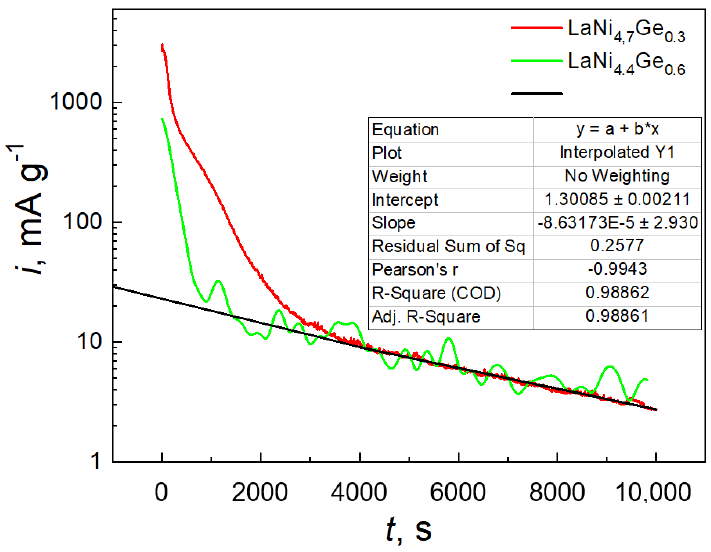
Figure 7. Chronoamperometric curves of LaNi 5-x Ge x composite electrodes at − 0.7 V (SCE).